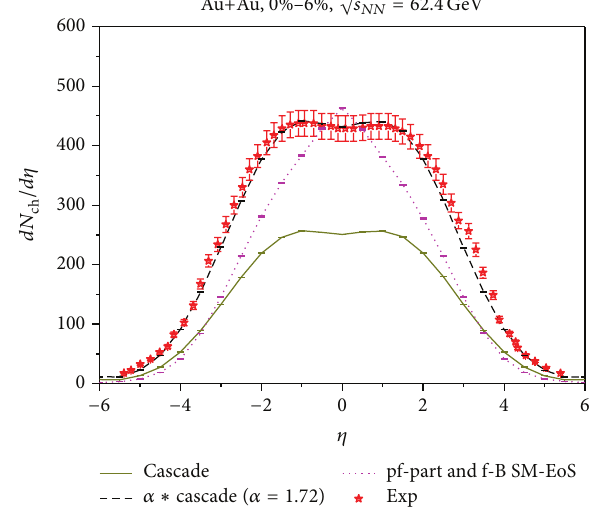
Figure 1: Charged particle pseudorapidity distributions for central Au+Au collisions at √𝑠 𝑁𝑁 = 62.4 GeV. Calculations with cascade and with potentials (“pf-part and f-B SM-EoS”) are shown by the curves. Experimental data taken from the PHOBOS collaboration [23] are represented by scatters.